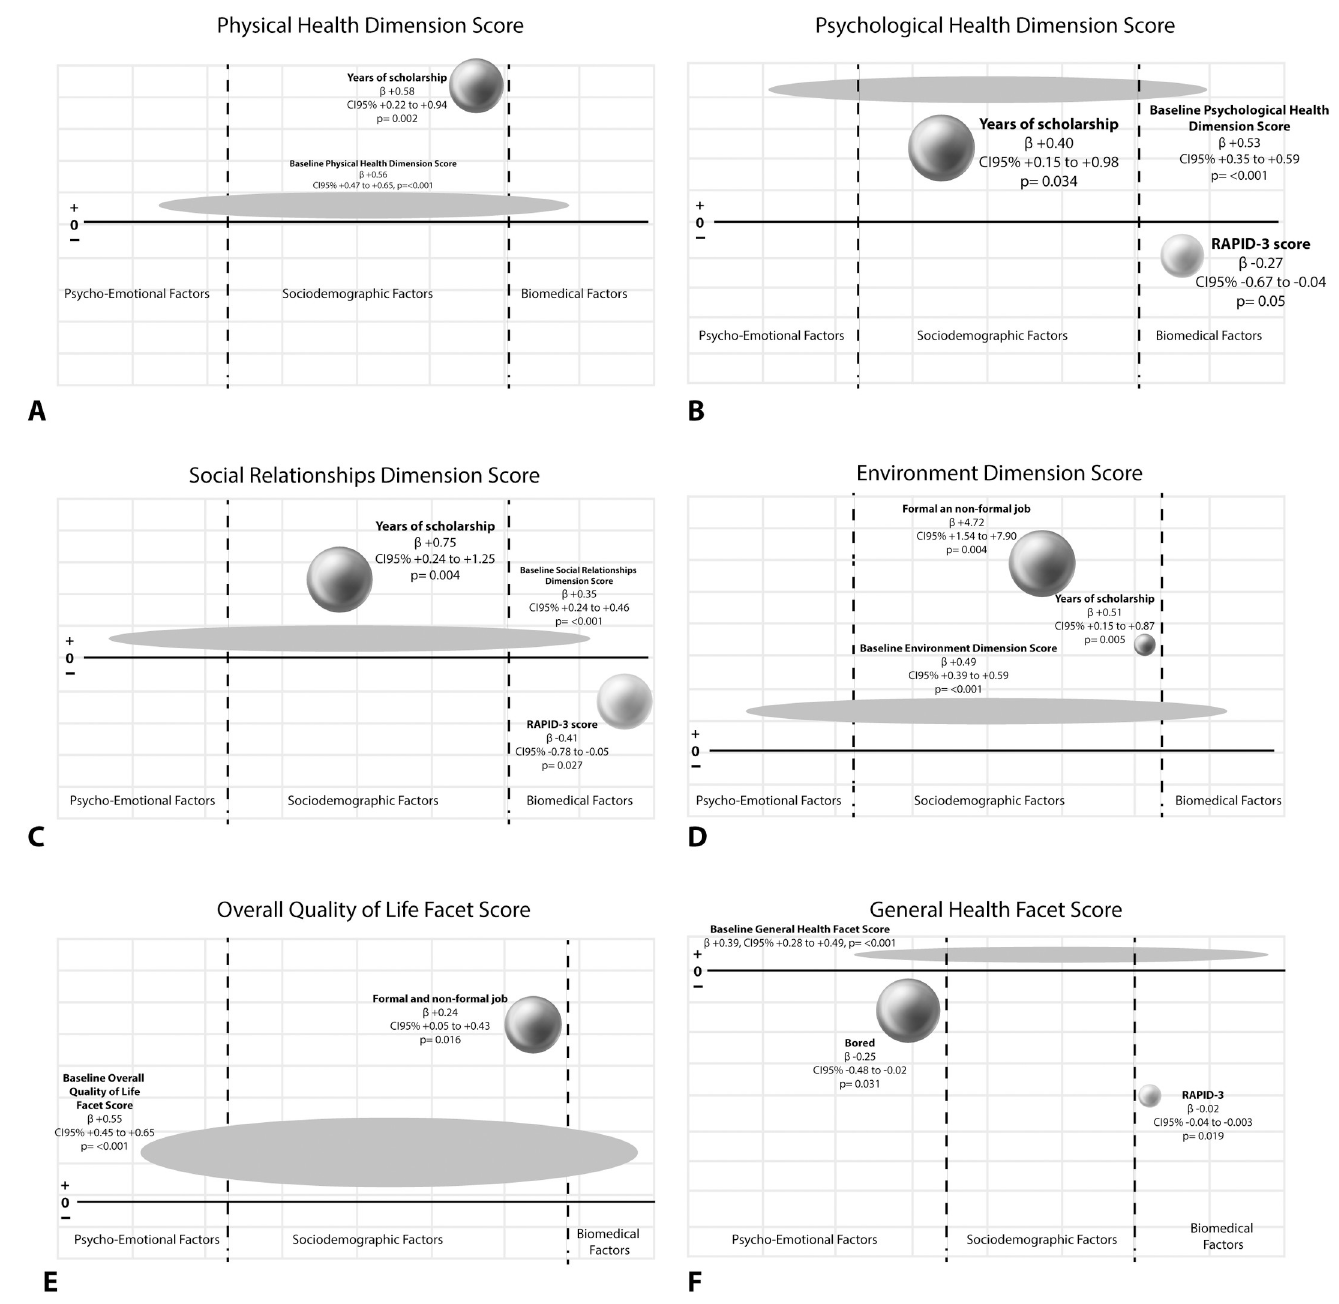
Fig 4. Factors associated with six-month follow-up QoL dimensions/facets scores: 4A Physical health dimension, 4B Psychological health dimension, 4C Social relationships dimension, 4D Environment dimension, 4E Overall quality of life facet and 4F General health facet. Factors associated with QoL dimensions and facets scores are distributed into three columns. The column located at the left side of the figure includes psycho-emotional factors, while the column located at the right side includes biomedical factors. Sociodemographic factors are located in the column left. The size of each sphere is in accordance with B coefficient magnitude (multivariate linear regression analysis). Meanwhile, the space between spheres does not meant to represent any relevant data.